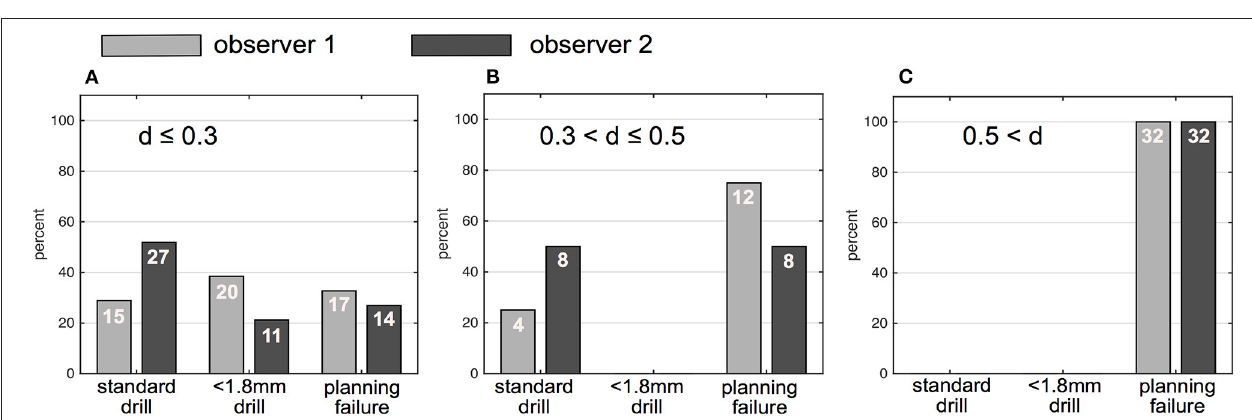
FIGURE 2 | Percentage and numbers (in white) of successfully planed ears based on drill bit size (1.8 and < 1.8mm) and percentage of unsuccessfully planned ears. (A) Ears planned on CT with ≤ 0.3mm slice thickness. (B) Ears planned based on CT with a slice thickness between 0.3 and ≤ 0.5mm. (C) Ears planned based on CT with a slice thickness > 0.5mm; gray bars indicate results of observer 1, black bars indicate results of observer 2; d (slice